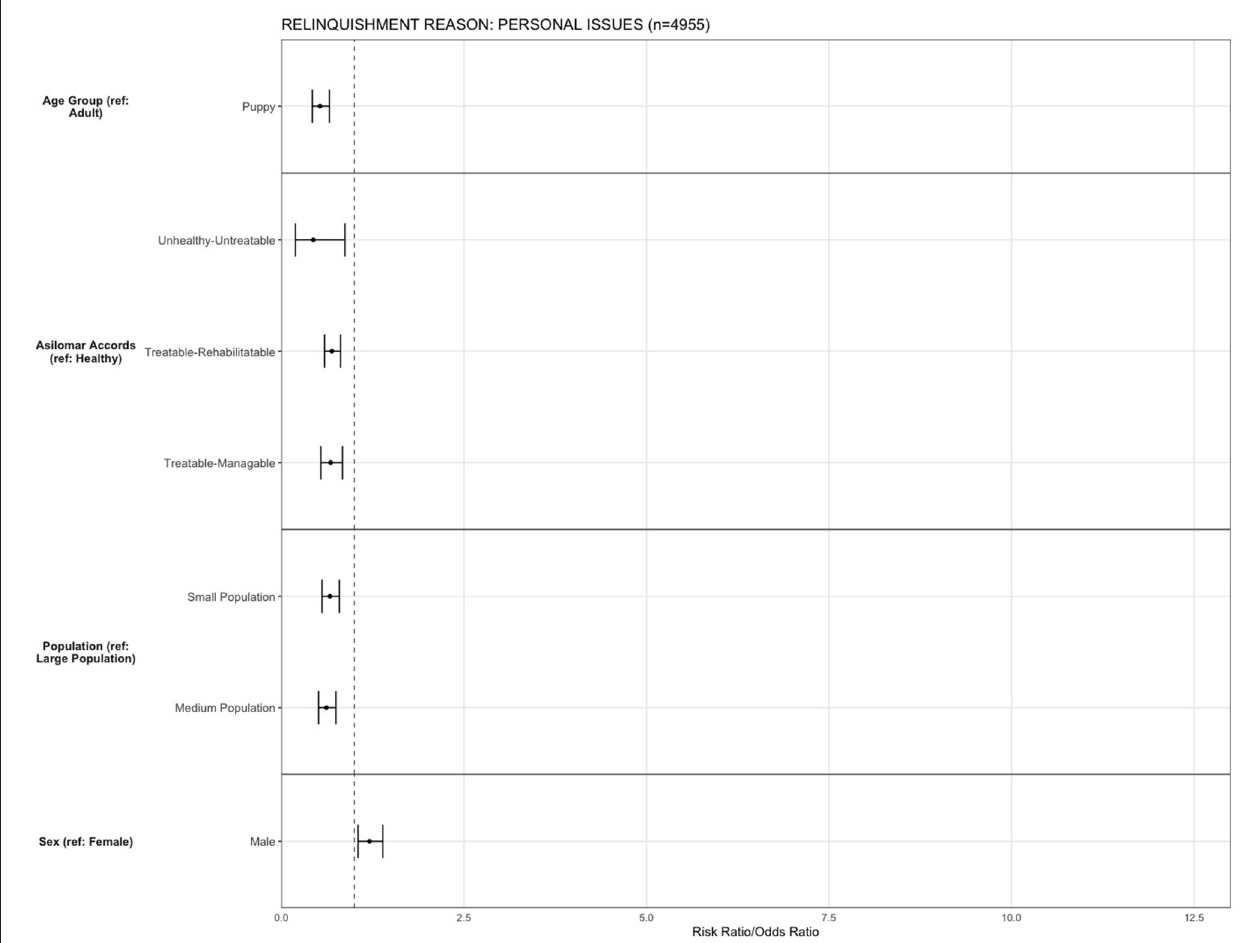
FIGURE 6 | The association between relinquishment reason and animal characteristics for puppies and dogs relinquished for the reason of “personal issues” ( n = 4,955). Characteristics include age group, Asilomar Accords category, breed type, dog size, sex, population center size, and year. The results of the logistic regression model are shown. Data are presented by risk ratios and their 95% confidence interval (bars); p < 0.05 when 95% confidence interval does not cross the vertical dotted line. A risk ratio > 1 suggests an increased risk of relinquishment of that the characteristic category, while a risk ratio < 1 suggests a reduced risk. Non-statistically significant results are excluded from the